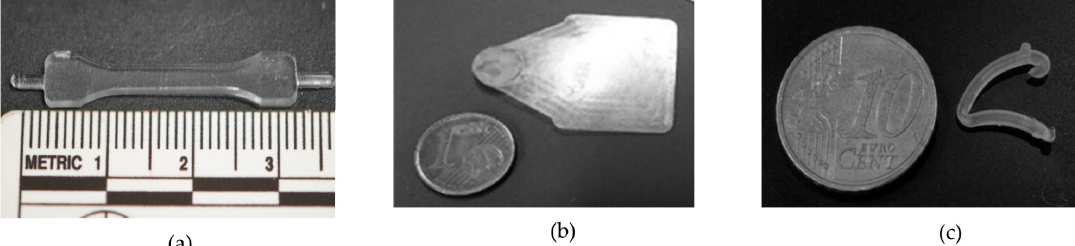
Figure 9. Miniature parts manufactured by ultrasonic injection molding in our facilities: ( a ) Micro-test specimen with 30 × 4 mm and 1 mm thickness; ( b ) degradable plate of 20 × 25 mm and 400 µm thickness and; ( c ) ligation system fabricated by Elias Grajeda et al. [53].